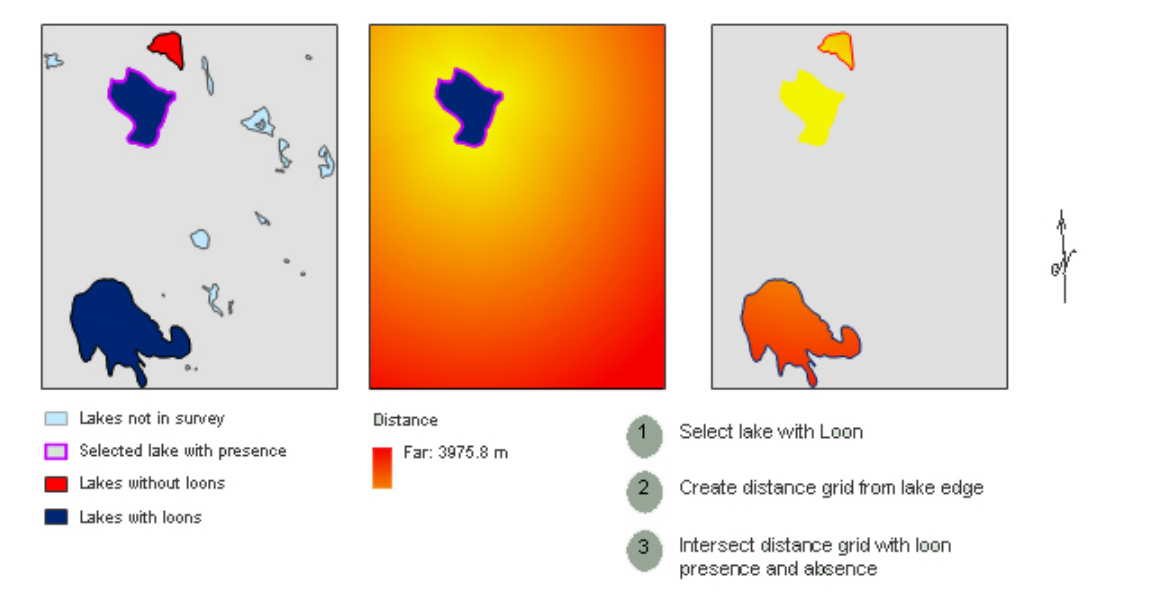
Fig. 5. Development of minimum Euclidian distance measured from the edge of a lake to the edge of the nearest lake with and without loons using